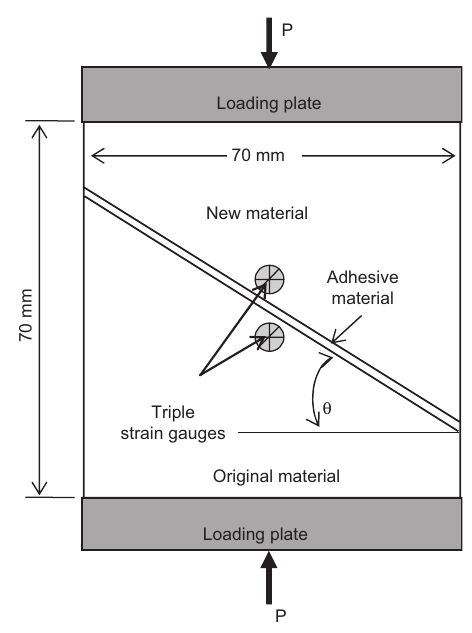
Figure 16 The confi guration and the dimensions of the prismatic composite specimens.